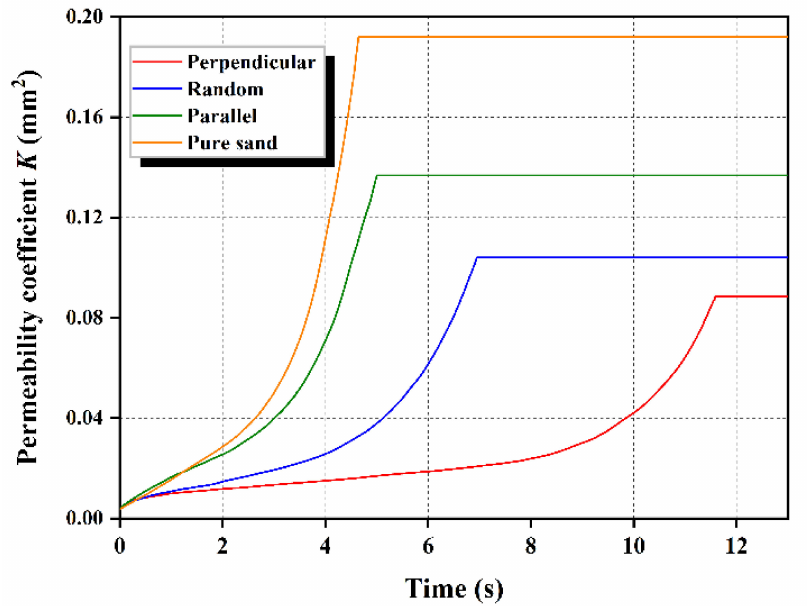
Figure 9. Permeability variation of pure sand and fiber-reinforced sand with seepage-induced